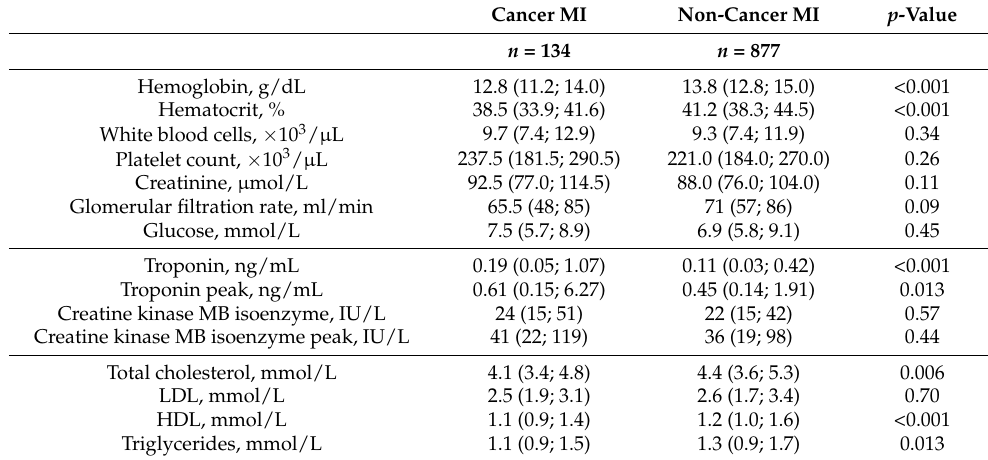
Table 2. Laboratory